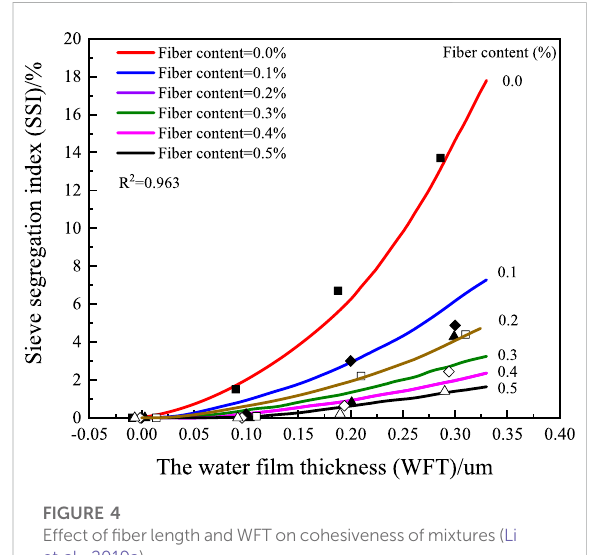
FIGURE 4 Effectof fi berlengthandWFToncohesivenessofmixtures(Li et al.,